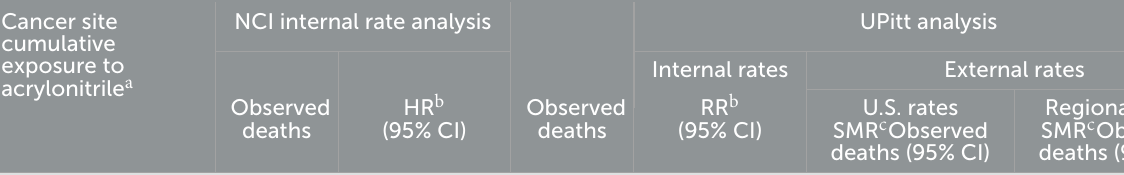
TABLE 2 Observed deaths, NCI internal rate-based HRs, and UPitt external rate-based SMRs (U.S. and regional rates) for selected causes of death by NCI cumulative acrylonitrile exposure category (lagged 10 years unless otherwise noted), full cohort, in the follow-up period